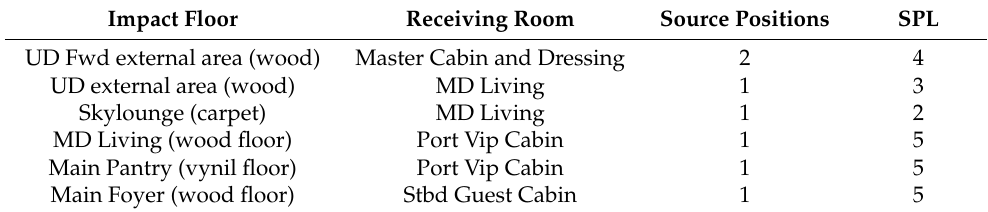
Table 4. Number of source positions and SPL measurements for each source position.